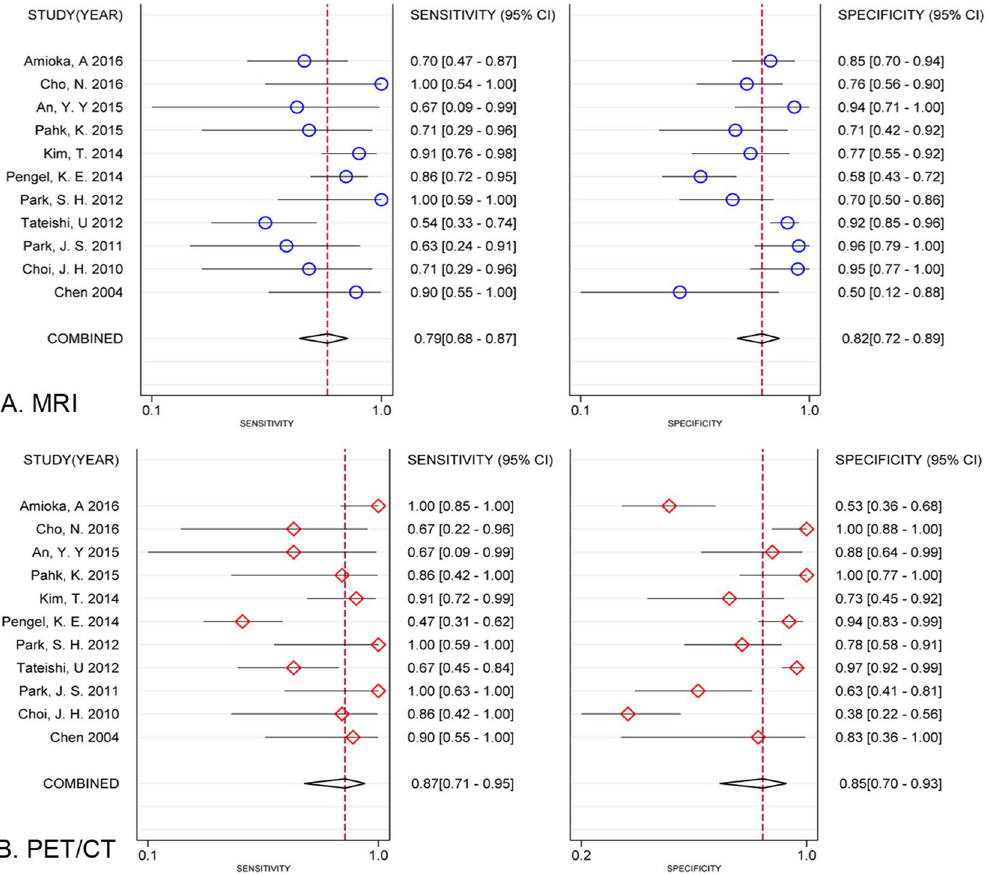
Figure 3. Forest plots of SEN and SPE with corresponding 95% CIs of MRI and PET/CT in assessing pathologic response to NAC. ( A ) MRI; ( B )